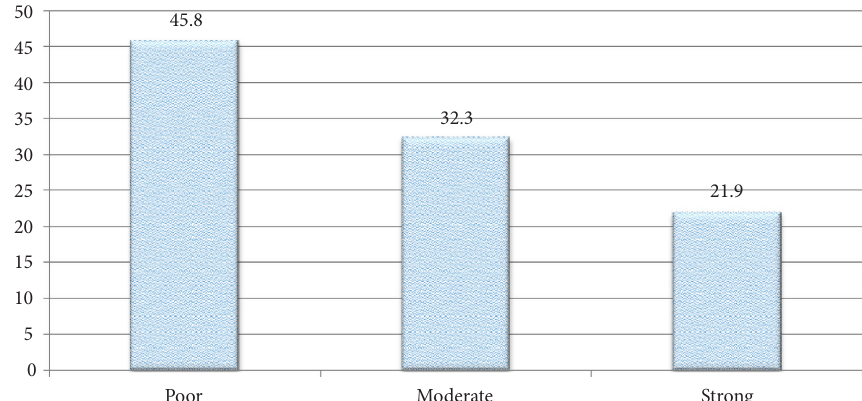
Figure 1: Percentage distribution of level of social support among adolescents aged 15–19 years at governmental high schools of Aksum Town, Tigray, Ethiopia, in 2019 ( n � 633). Table 2: Bivariate and multivariate logistic analysis of factors associated with alcohol use among adolescents aged 15–19 years at gov- ernmental high schools of Aksum town, Tigray, Ethiopia, in 2019 ( n �